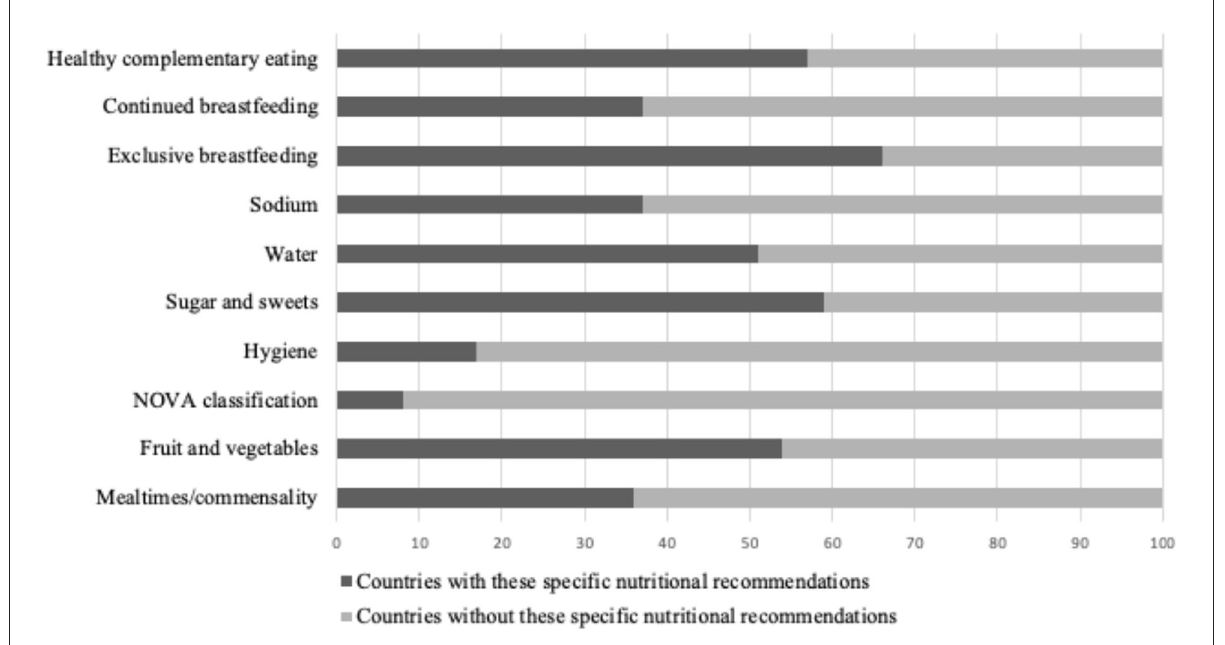
FIGURE7 Percentage distribution of countries with specific nutritional recommendations in their